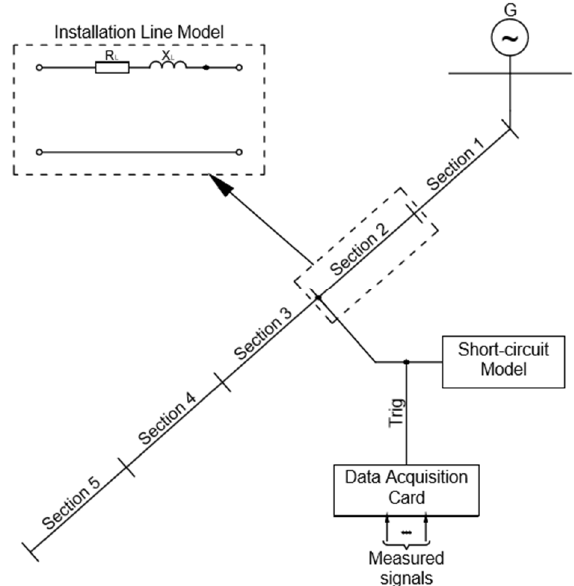
Figure 2. The outside ( a ) and inside ( b ) view on the short-circuit module.